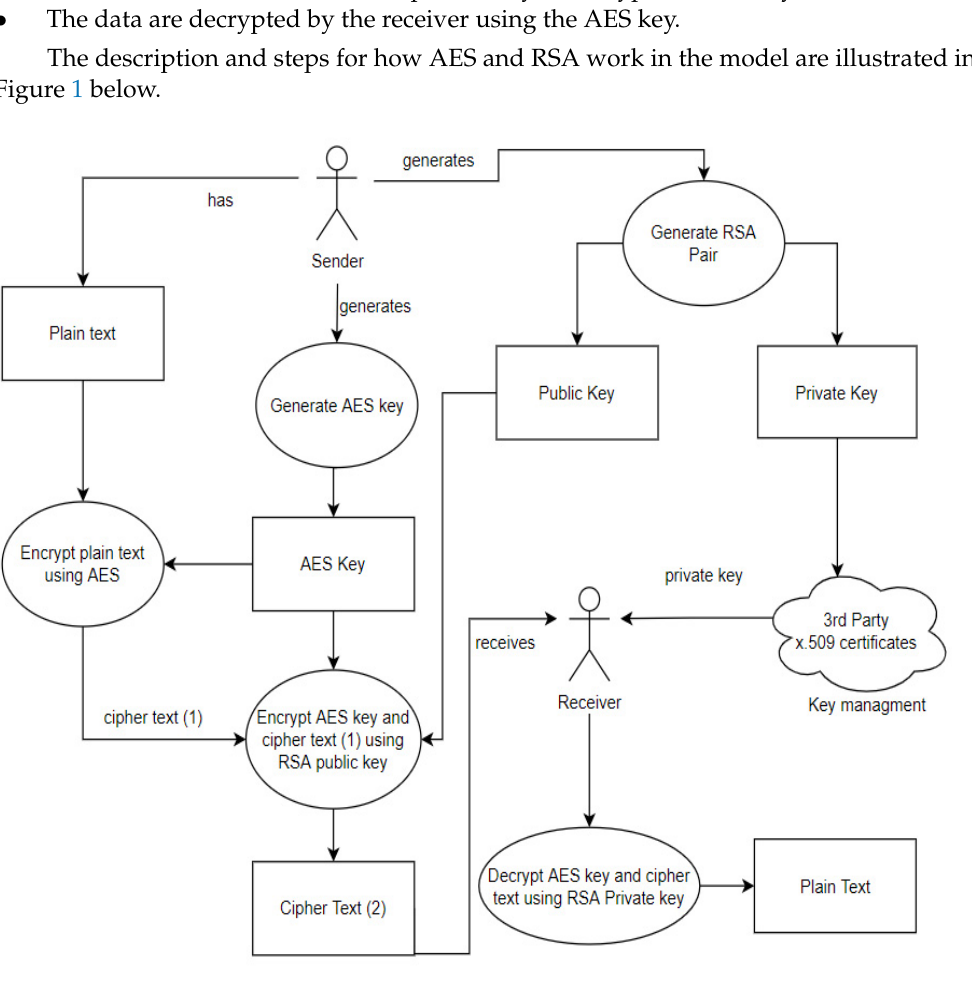
Figure 1. A description of how AES and RSA work in the first